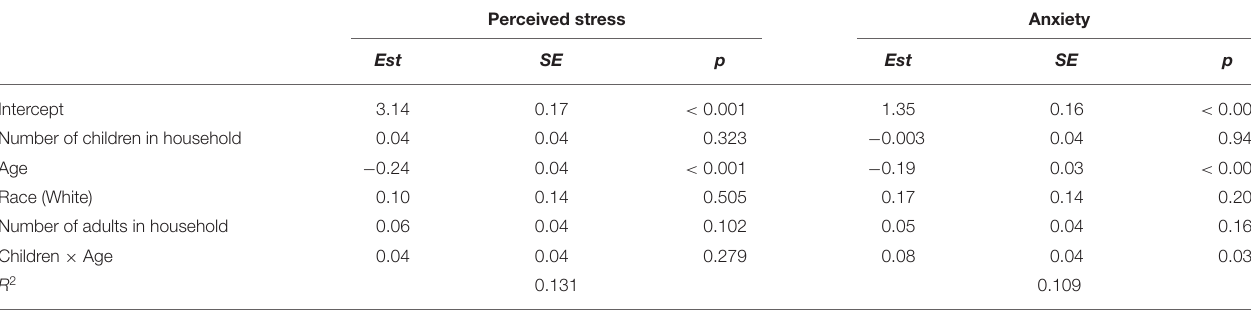
TABLE 3 | Multiple regression models estimating the extent to which number of children in household is associated with perceived stress and anxiety. Perceived stress